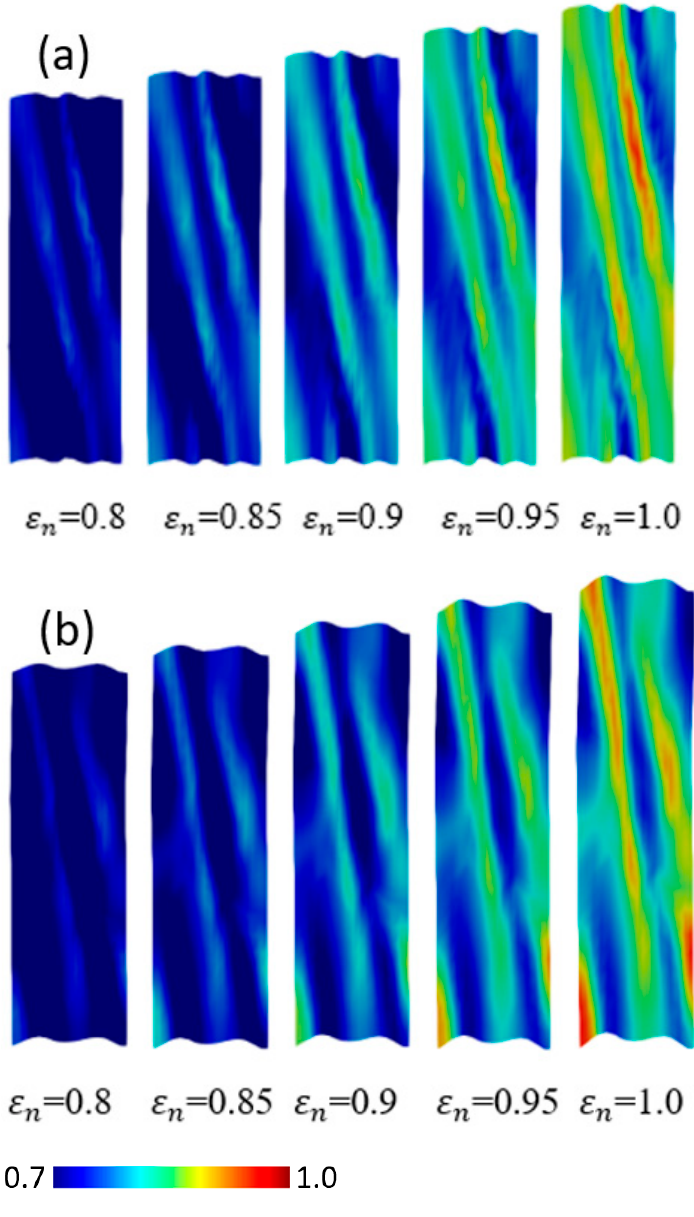
Figure 21. The distribution of the equivalent plastic strain of 4-grain polycrystal TRIP steel with different mesh sizes ( a ) coarse mesh, and ( b ) fine mesh.